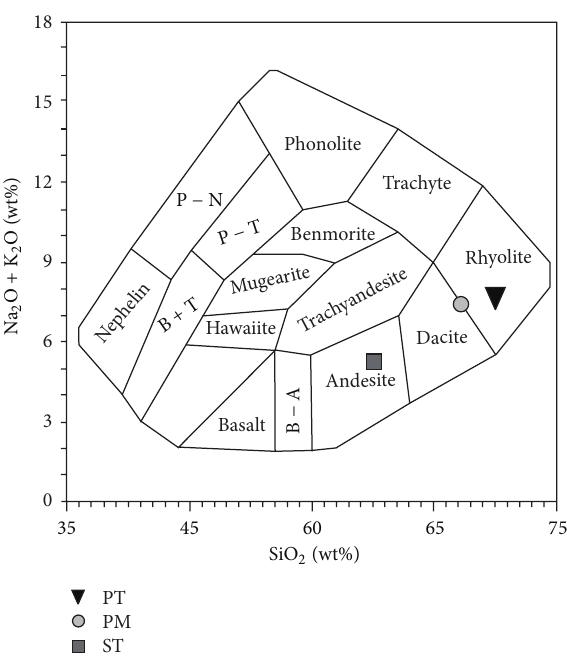
Figure 3: Total alkali-silica (TAS) plot for PT, PM and ST samples.